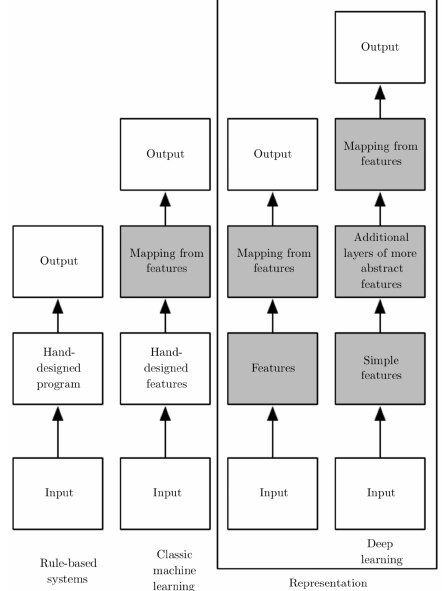
Figure 2. Different approaches in AI for data classification. Grey boxes show modules that can learn from data (Goodfellow et al.,